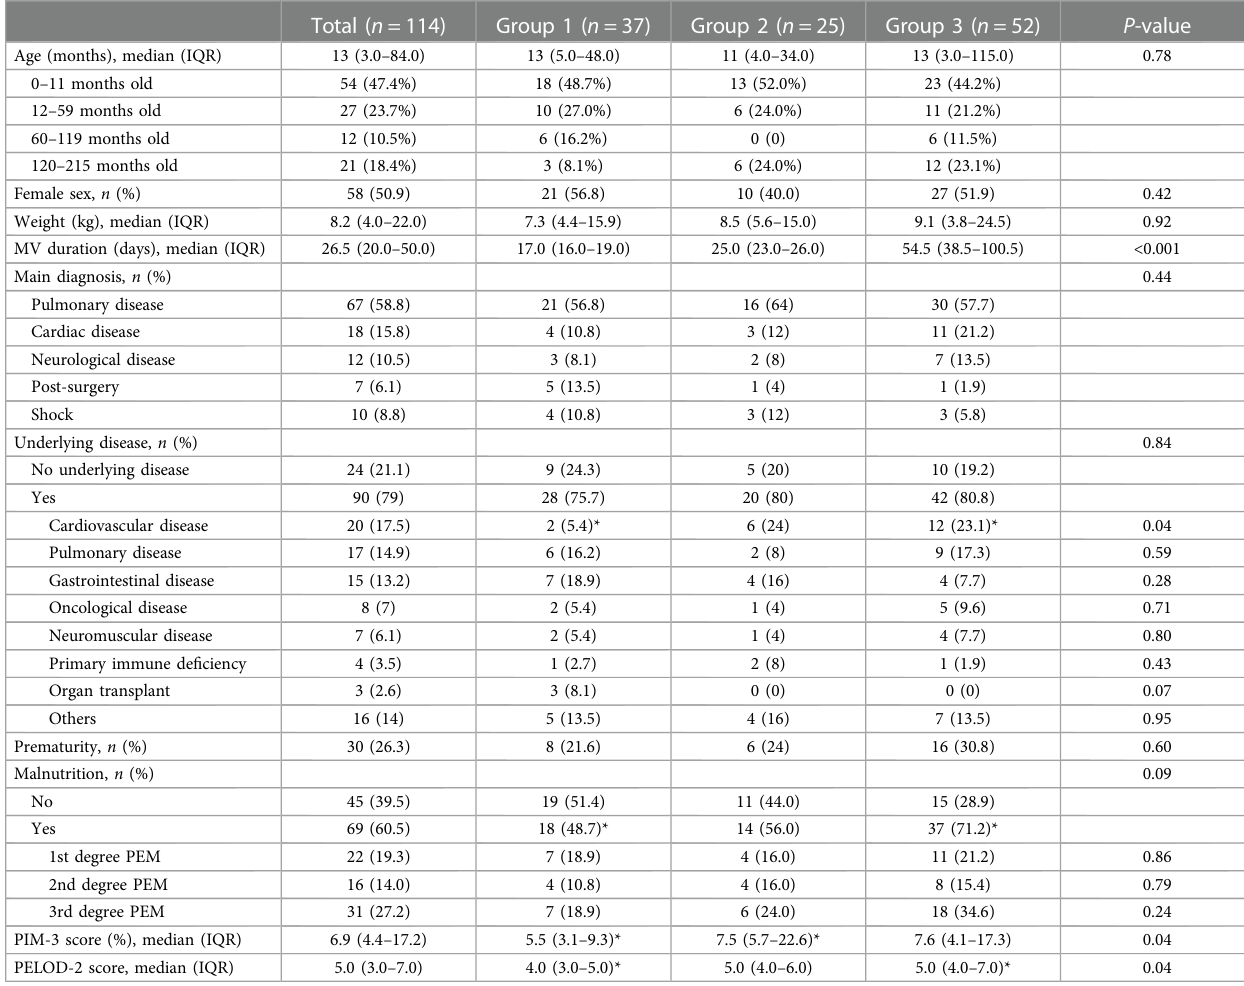
TABLE 1 Demographic and baseline data